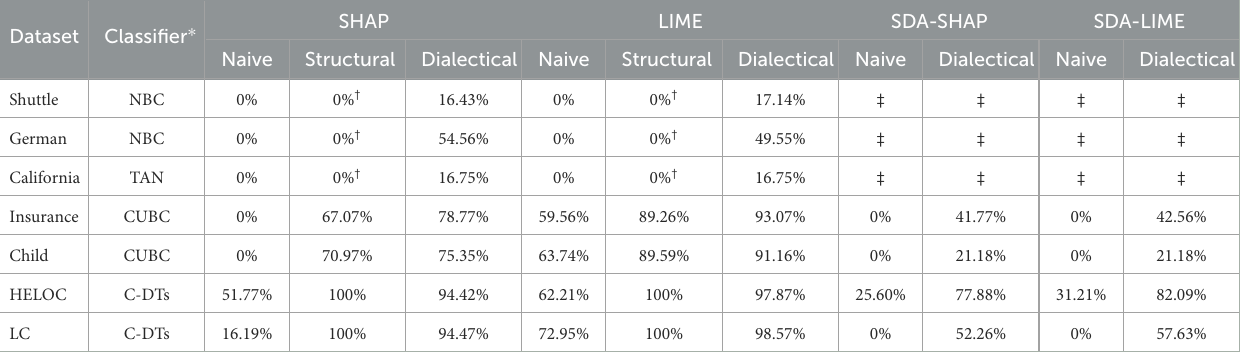
TABLE 4 Average percentages of reasons (over 100 samples) violating DA (i.e., |{ ( V i , V j ) ∈ R − ∪ R + such that( V i , V j ) violates DA }| / | R − ∪ R + | ) for several instantiated RXs.